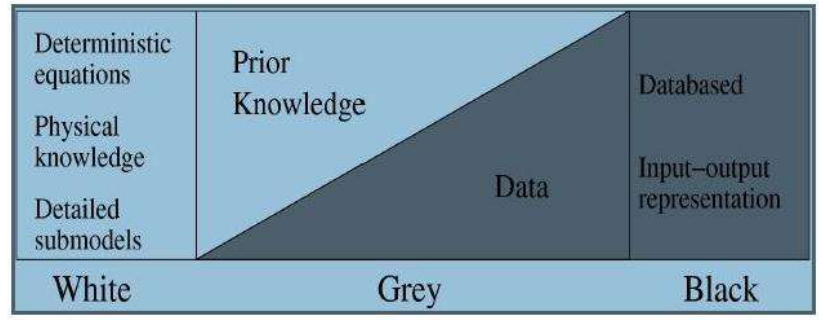
Figure 1. Grey box modeling [19].